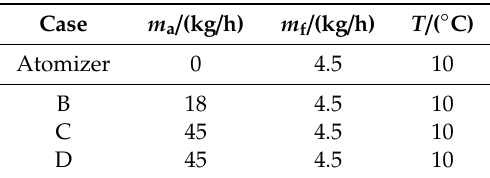
Figure 6. Liquid film breakup processes of different air-blast atomizer structures (Transient results). Table 2. Experiment conditions.